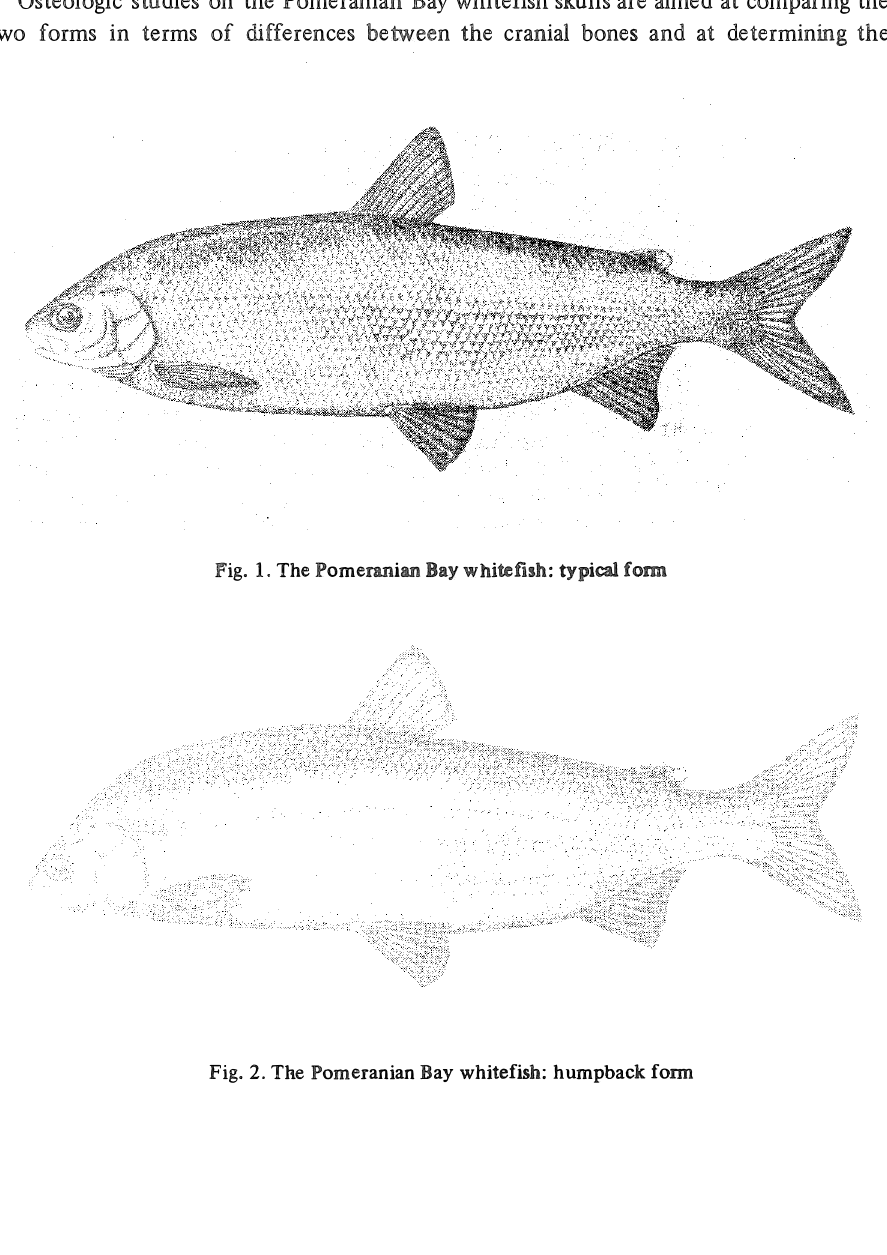
Fig. 2. The Pomeranian Bay whitefish: humpback